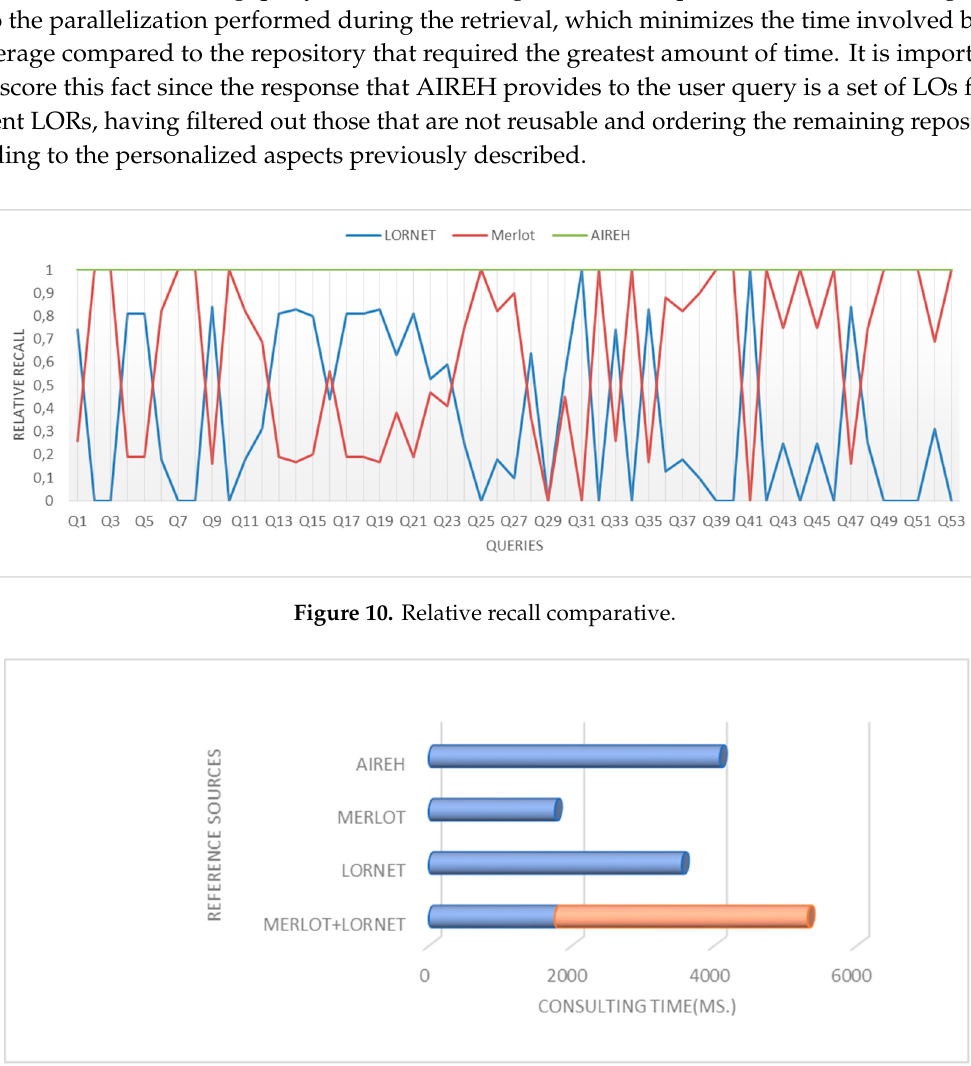
Figure 9. Comparative precision results for the architecture proposed.